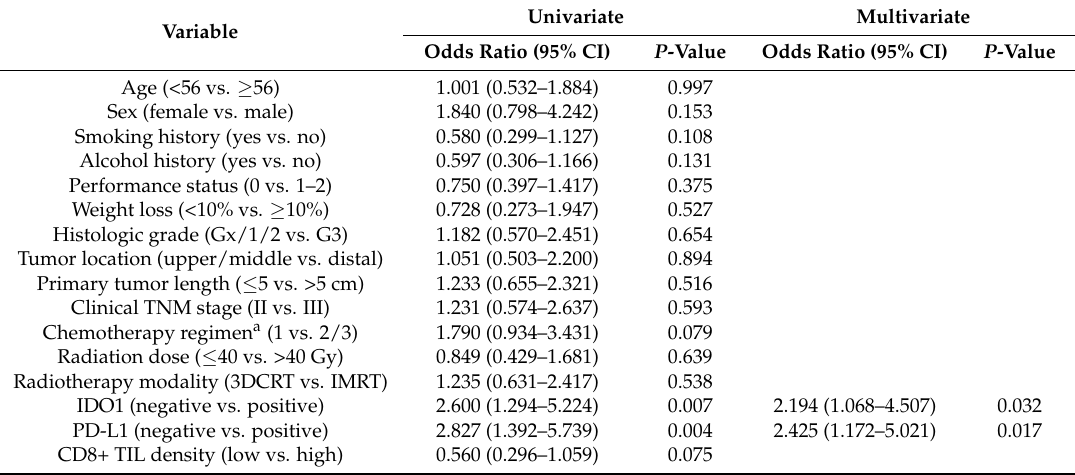
Table 3. Univariate and multivariate analyses for variables associated with pathologic complete response.